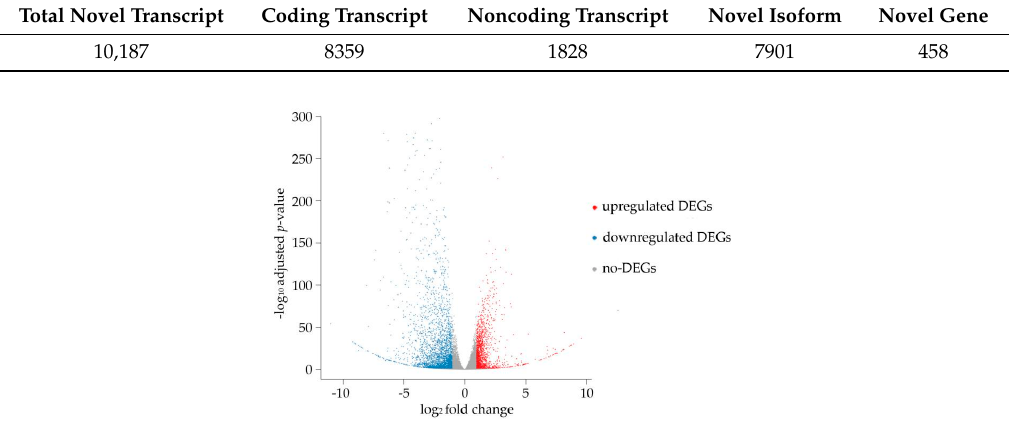
Figure 3. Volcano-Plot of differentially expressed genes (DEGs) of pine wood nematodes in aseptic condition and with S. maltophilia . The number of upregulated DEGs (log 2 fold change ≥ 1, adjusted p -value ≤ 0.05) is 1477, the number of downregulated DEGs (log 2 fold change ≤ − 1, adjusted p -value ≤ 0.05) is 2763, the number of no-DEGs (absolute value of log 2 fold change < 1 or adjusted p -value > 0.05) is 11,942.